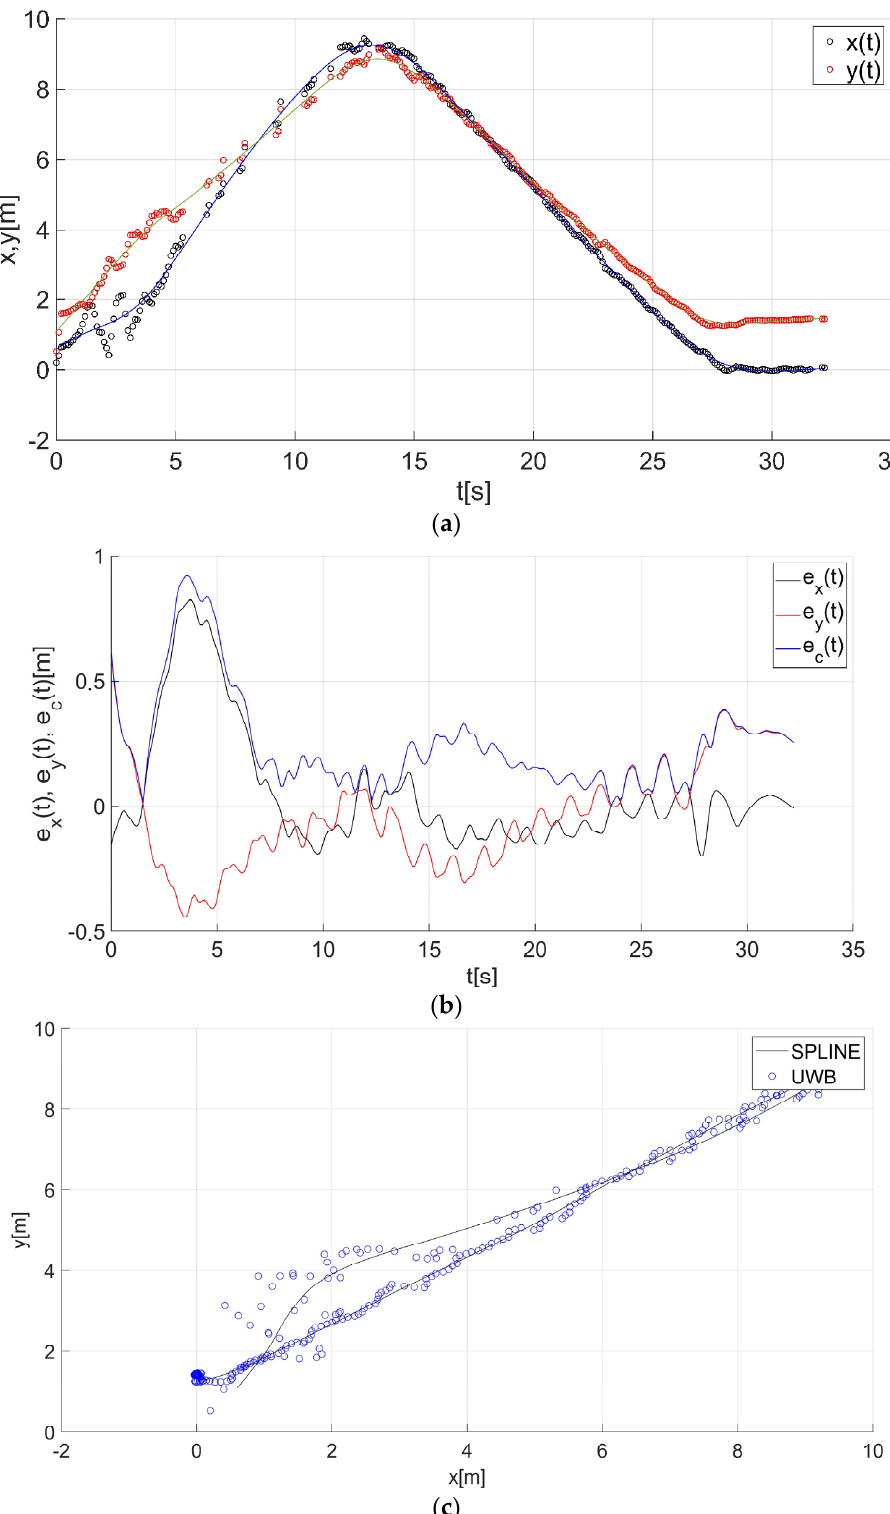
Figure 18. Results for the estimation of guide path no. 6 with the use of smoothing spline: ( a ) the course of the guide’s location coordinates x(t), y(t) with their continuous estimates, ( b ) the course of the estimated location errors e x (t), e y (t), e c (t), ( c ) guide’s location along with the path estimation [6].